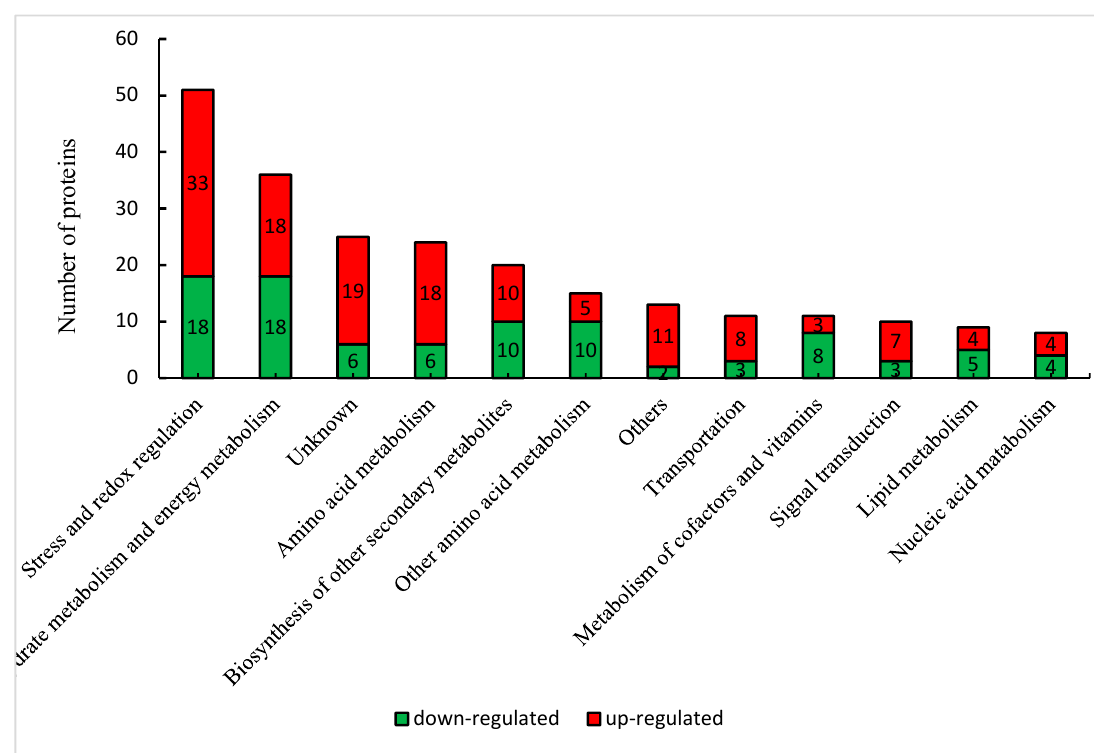
Figure 4. Functional classification of DEPs under drought stress.